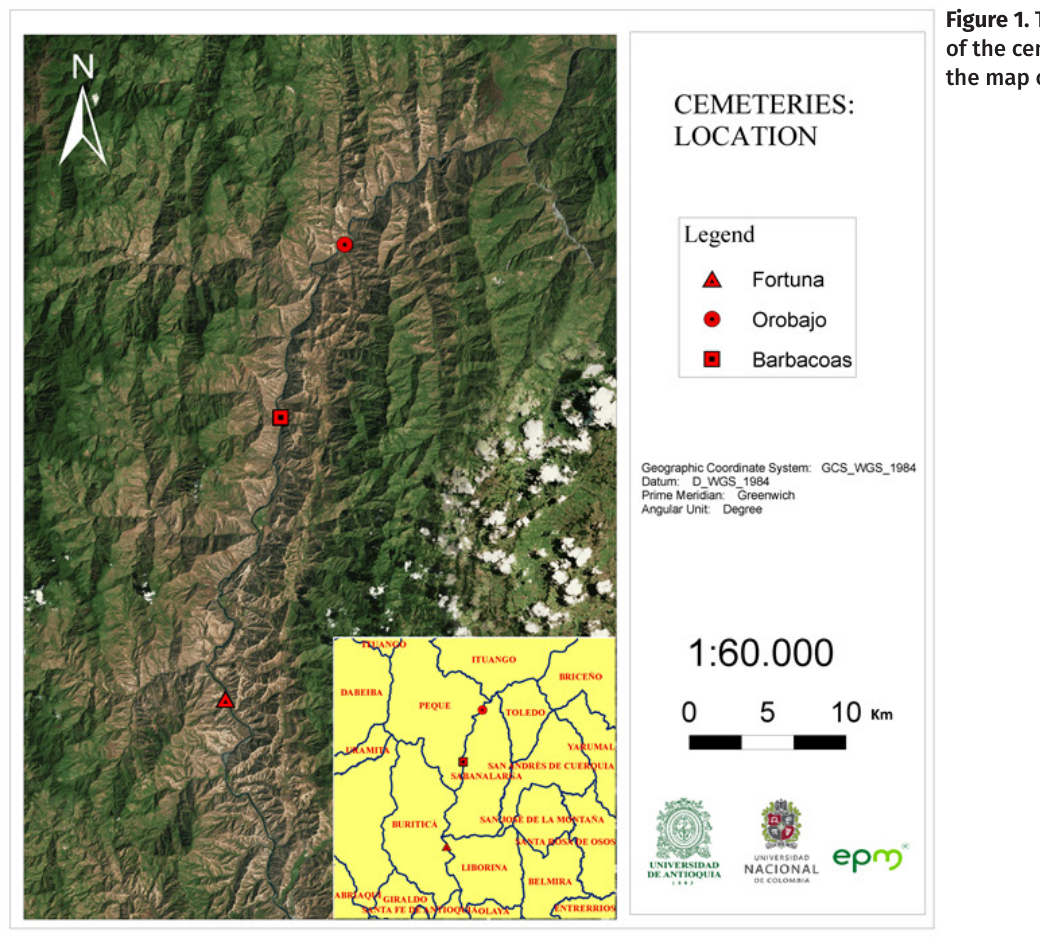
Figure 1. The location of the cemeteries in the map of